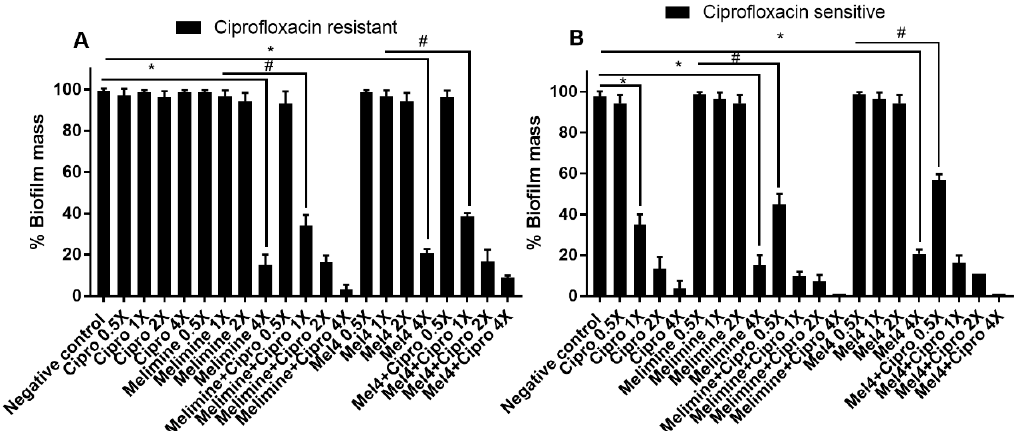
Figure 4. Disruption of pre-established biofilm of P. aeruginosa ATCC 27853. Biofilms of the ciprofloxacin-resistant ( A ) and sensitive ( B ) cells of P. aeruginosa ATCC 27853 were disrupted at various concentrations by melimine, Mel4 and ciprofloxacin alone or in combination. * represents significant ( p < 0.001) decrease compared to the negative control (biofilm treated with bu ff er). # indicates significants ( p < 0.001) decrease for the combinations compared to melimine or Mel4 alone. Means ( ± SD) of three independent repeats in triplicate. Negative control = bacteria grown in the absence of antimicrobials. Cipro = ciprofloxacin.